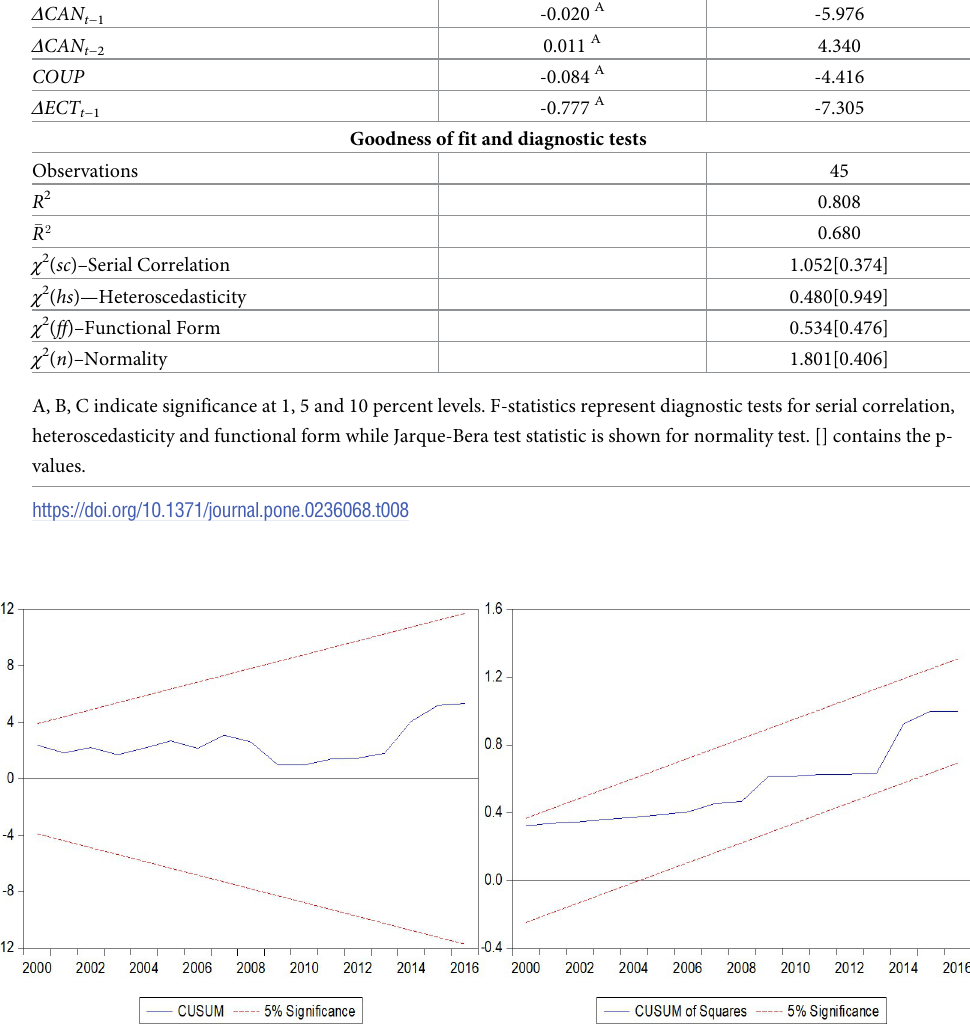
Fig 1. Model (4) CUSUM and CUSUM of squares test. CUSUM and CUSUM of Squares are tests for model stability. At 5 percent significance level, the lines stay within the critical bounds, indicating long-run model